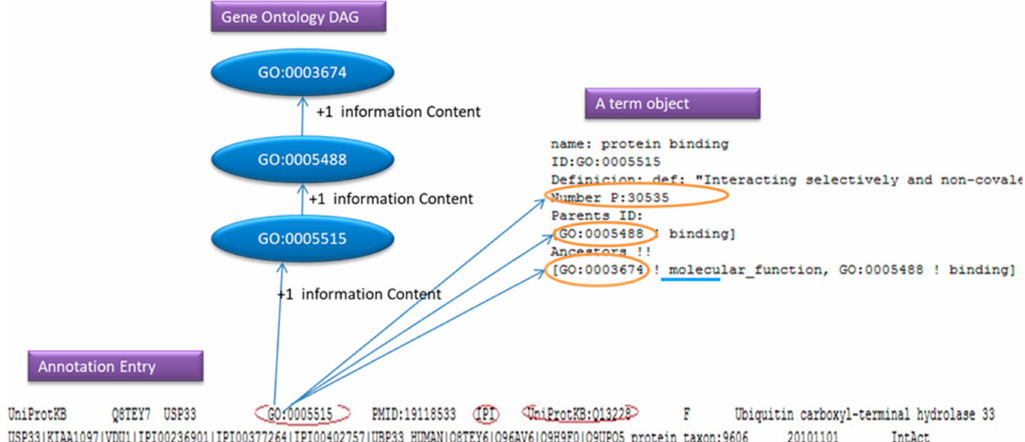
Figure 6. An annotation